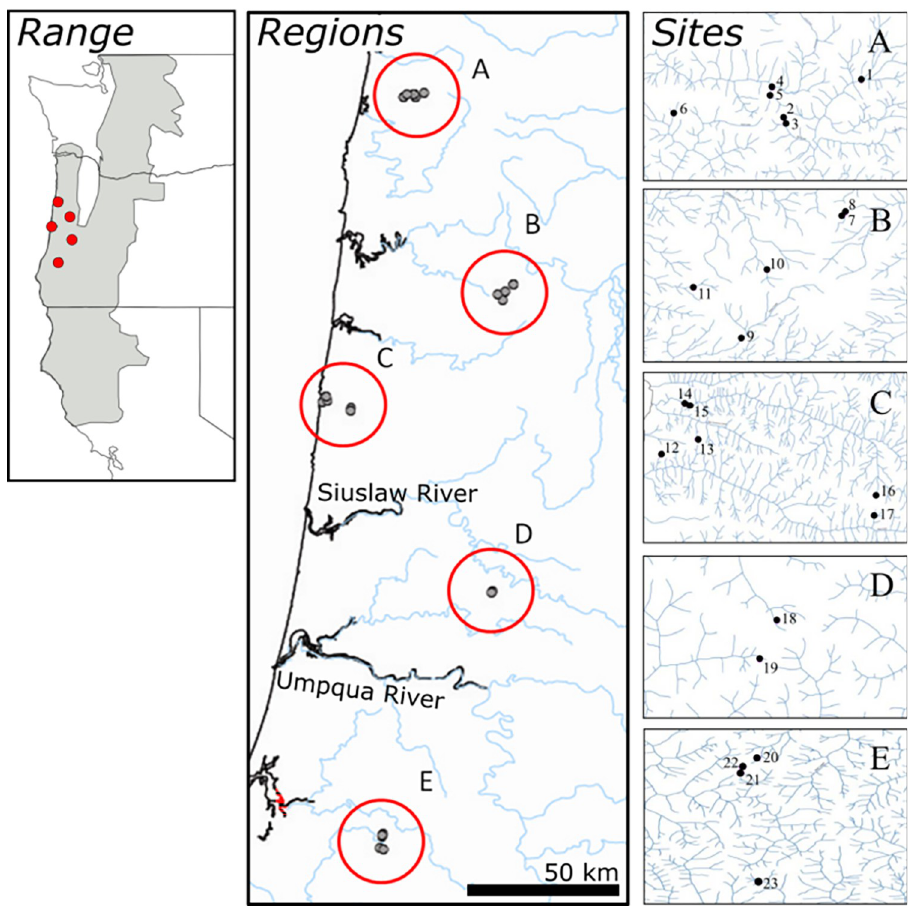
Fig 1. Sampling localities. The geographic range of coastal giant salamanders (left panel) showing the five sampled regions (center panel: circles A–E) along the coast of Oregon, USA, and details of sampled sites (labeled from 1 to 23; right panel; modified from Marcha´n-Rivadeneira, 2015 [52]). The left panel features species range information created using the IUCN Red List of Threatened Species [53] and other maps feature waterways from United States Geological Survey